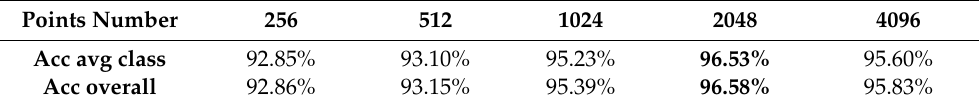
Table 1. Accuracy on different numbers of input points.